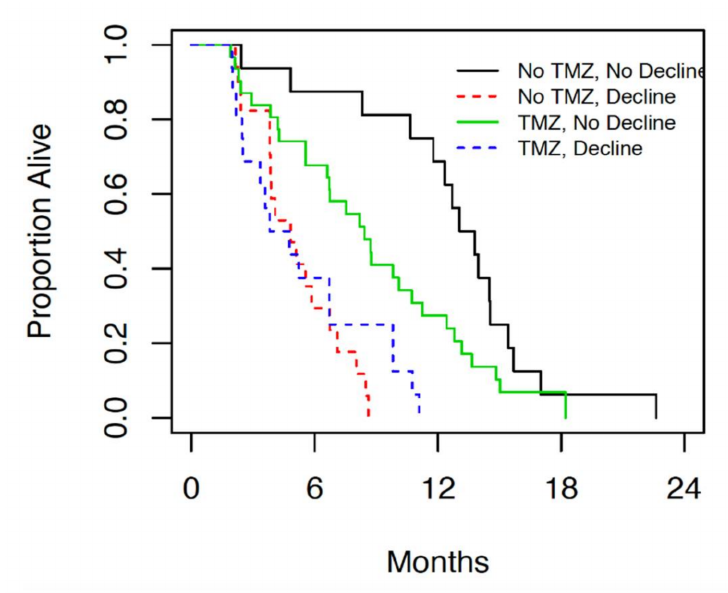
Figure 4. Median overall survival in patients who were treated with radiation alone (no TMZ) and chemoradiation (TMZ) subdivided further by neurologic decline post treatment. The incidence of neurologic decline following both radiation alone and chemoradiation was significantly higher in patients with borderline performance status compared to those with good performance